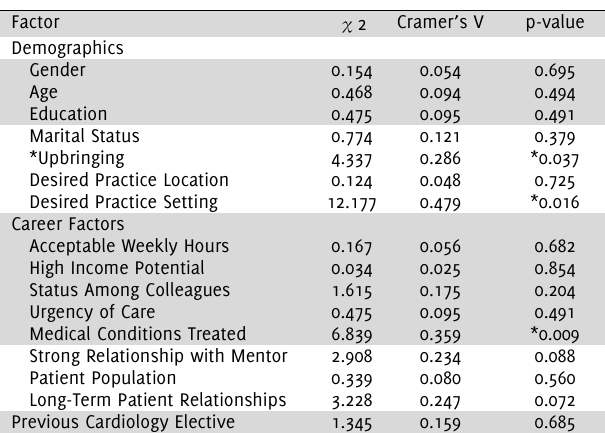
Table 2 . The Impact of Demographic, Career Factors and Previous Cardiology Electives on Interest in Cardiology.